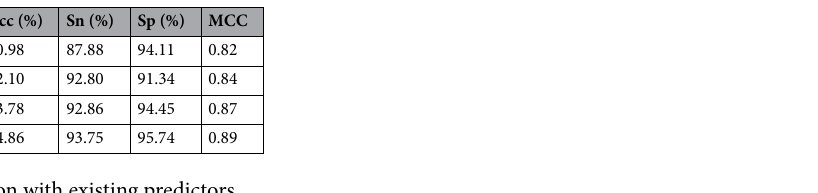
Table 4. Comparison with existing predictors.